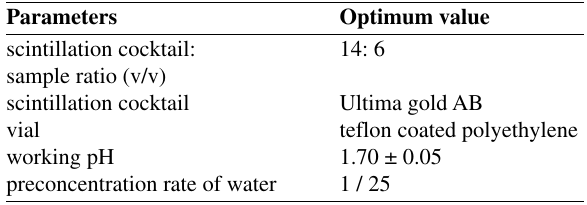
Table 2. Optimum measurement conditions